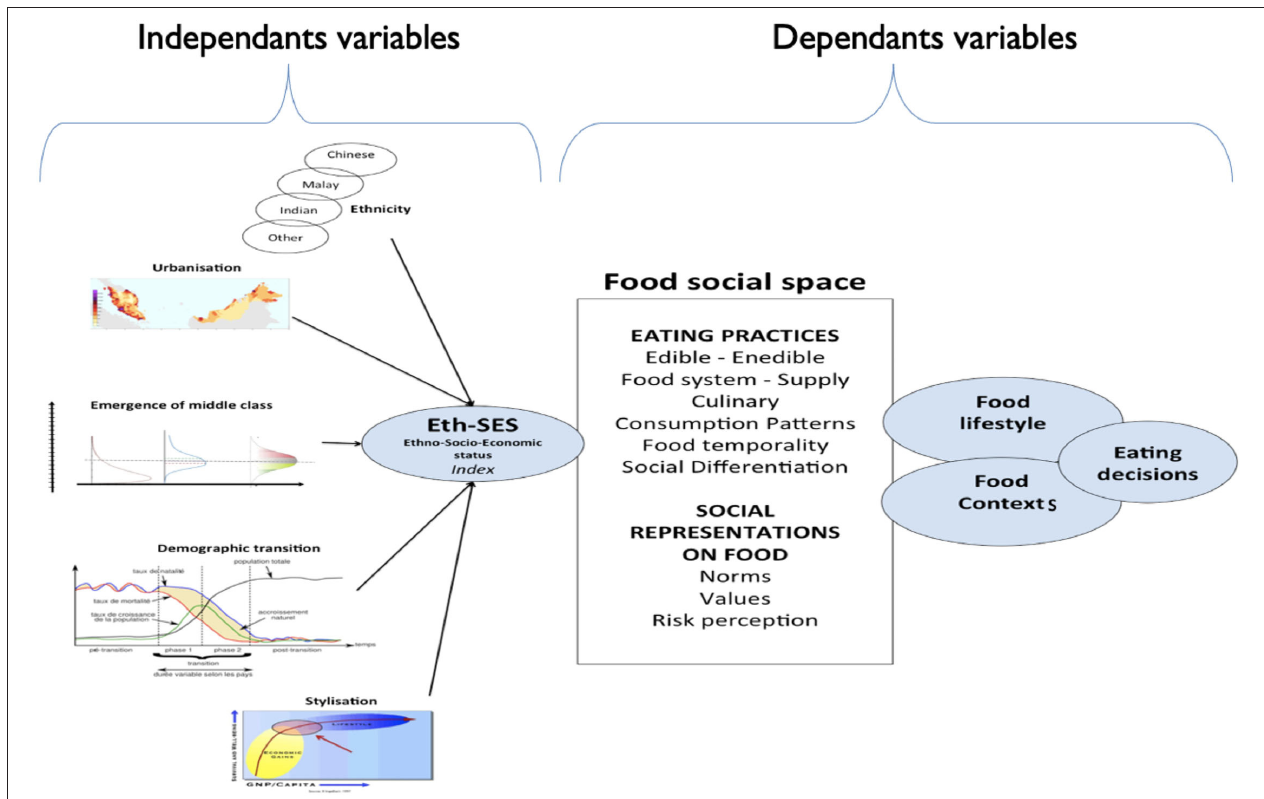
FIGURE 1 | Malaysian Food Barometer (MFB) conceptual